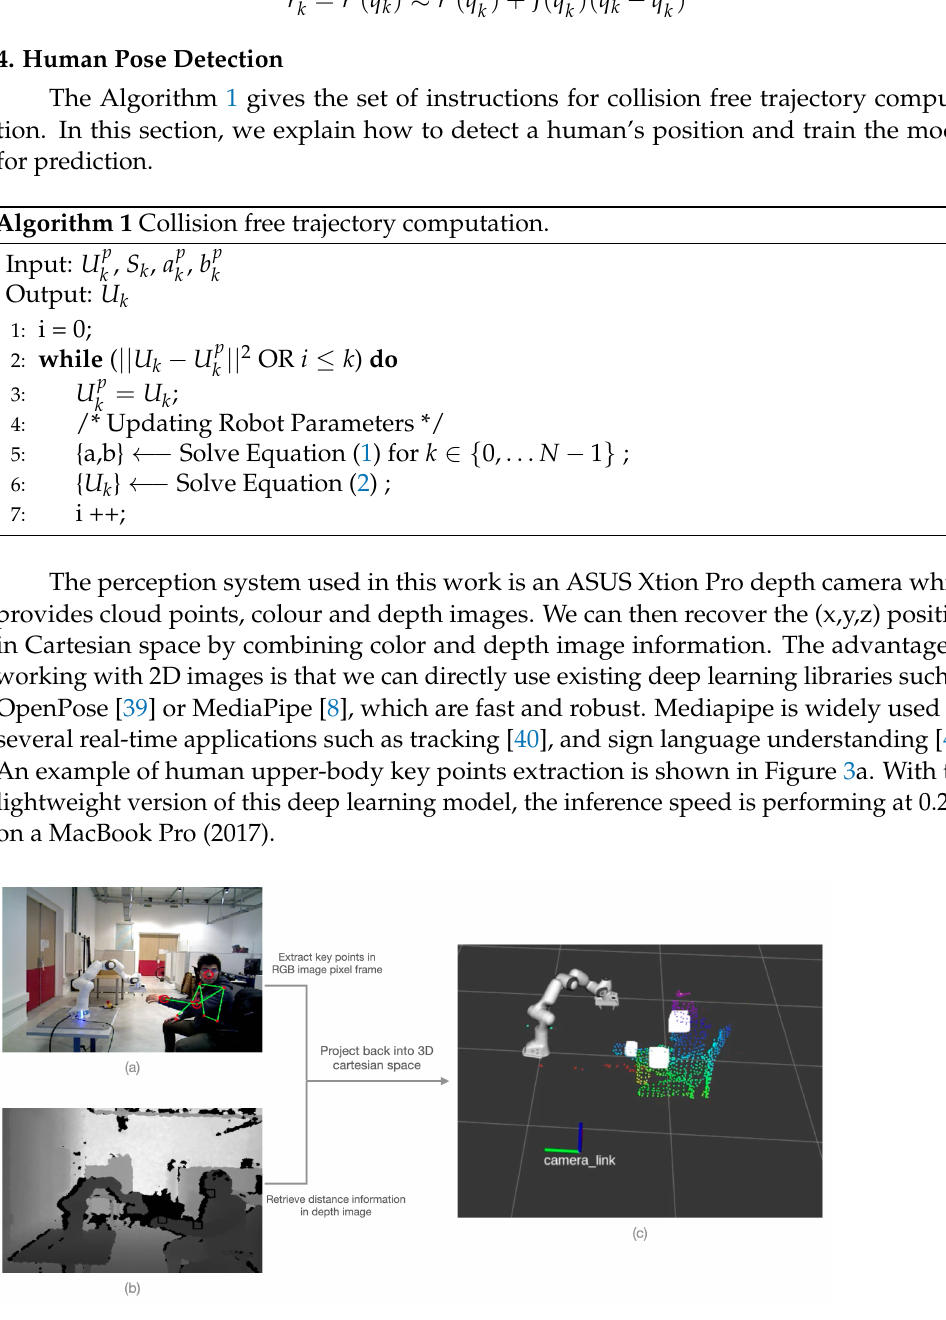
Figure 3. Example demonstration of RGB-D image for mapping human hand in 3D space, ( a ) shows RGB image on which hand joins are detected, ( b ) shows the bounding box around the points in the depth image, and ( c ) shows the mapping of points in 3D